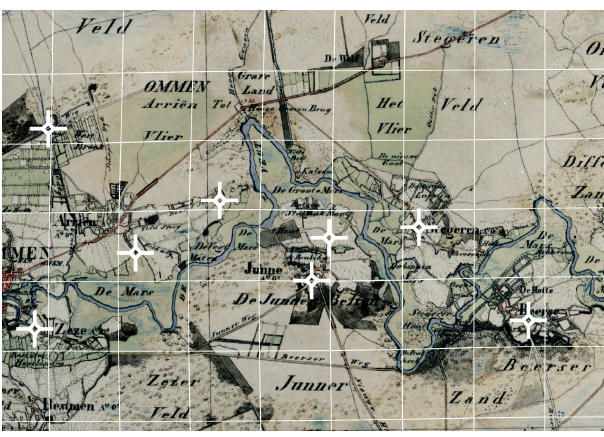
Figure 4. Section of the georeferenced historical map of 1851 CE (details listed in Table 1), displaying ground control points (white crosses) and a distortion grid (in white; maze size of 1km).